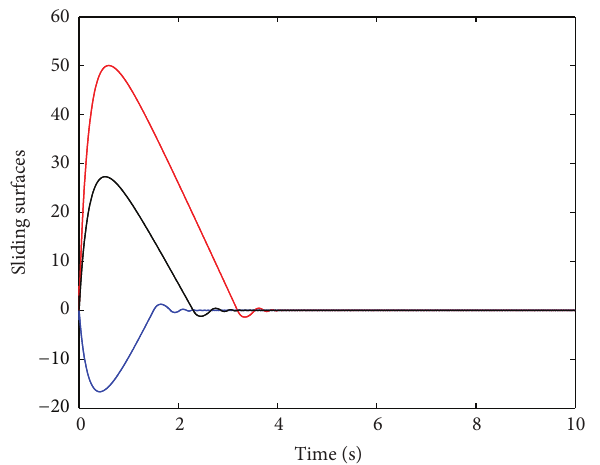
Figure 5: Sliding surfaces states with 𝛼 = 0.5 (red line represents the first sliding surface state 𝑠 1 , blue line represents the second sliding surface state 𝑠 2 , and black line represents the third sliding surface state 𝑠 3